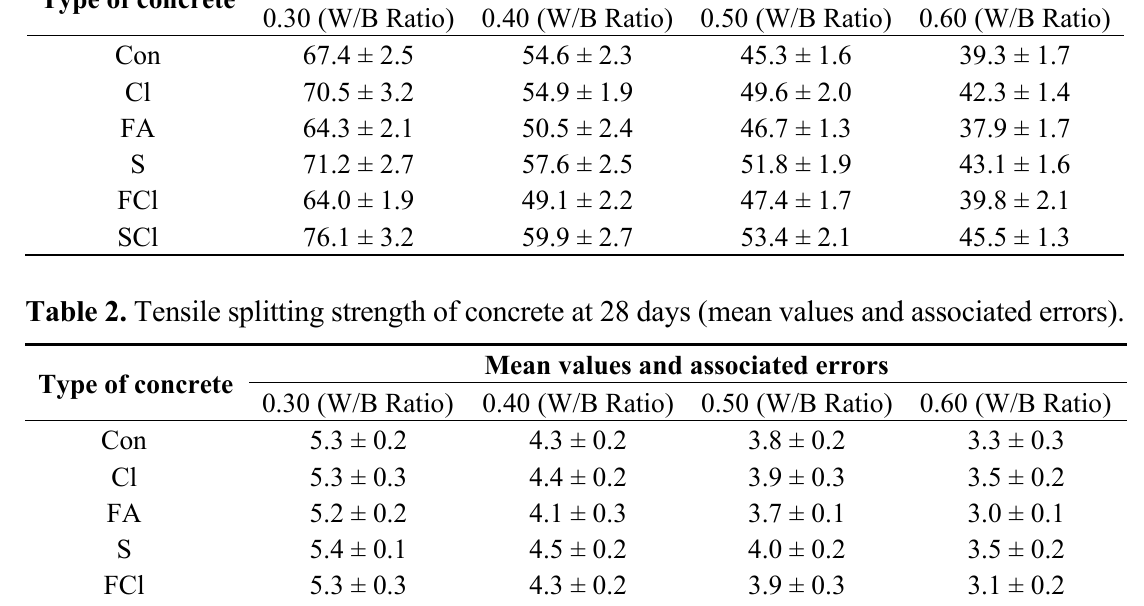
Table 1. Compressive strength of concrete at 28 days (mean values and associated errors). Type of concrete